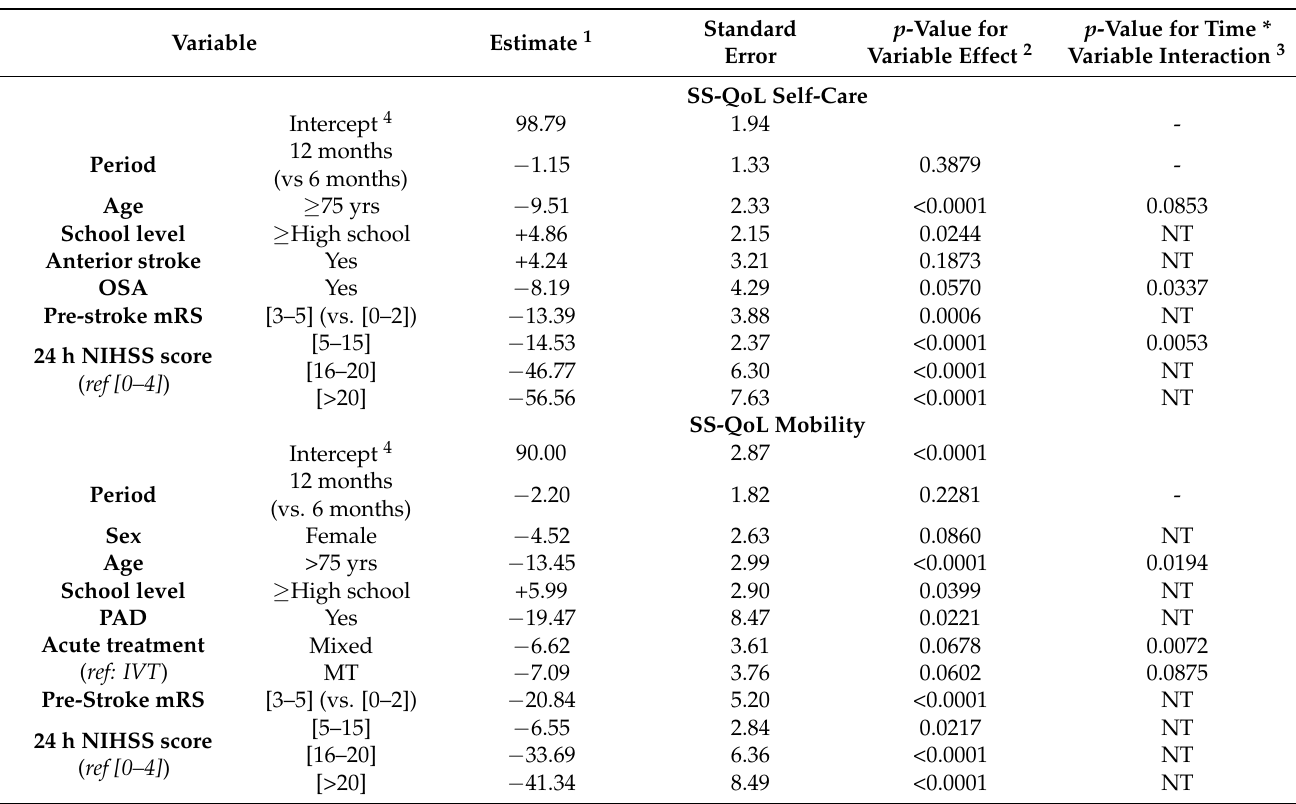
Table 4. Multivariate analysis of characteristics associated with the SS-QoL domains self-care and mobility.